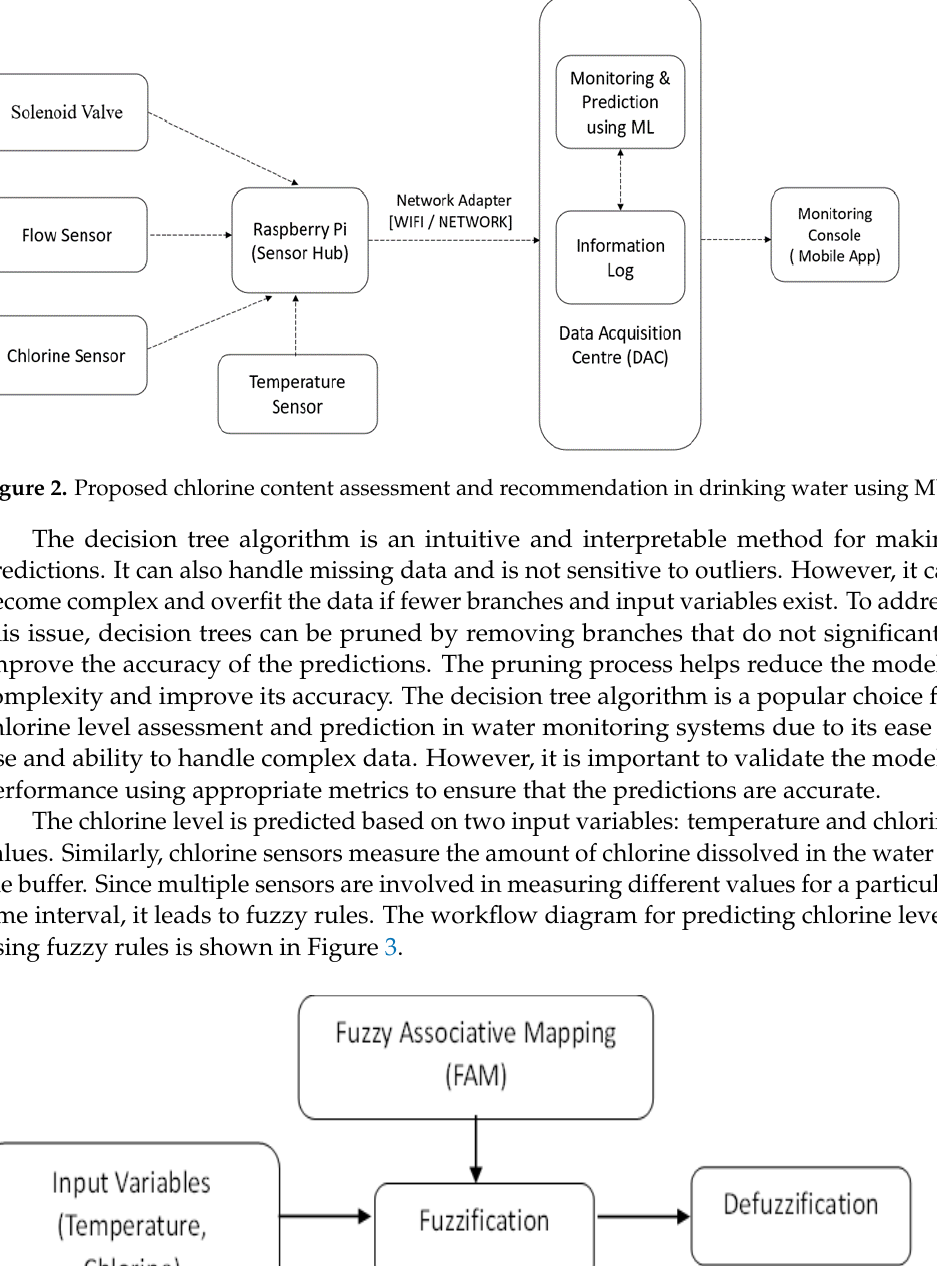
Table 1. Sample rule for predicting the water quality.